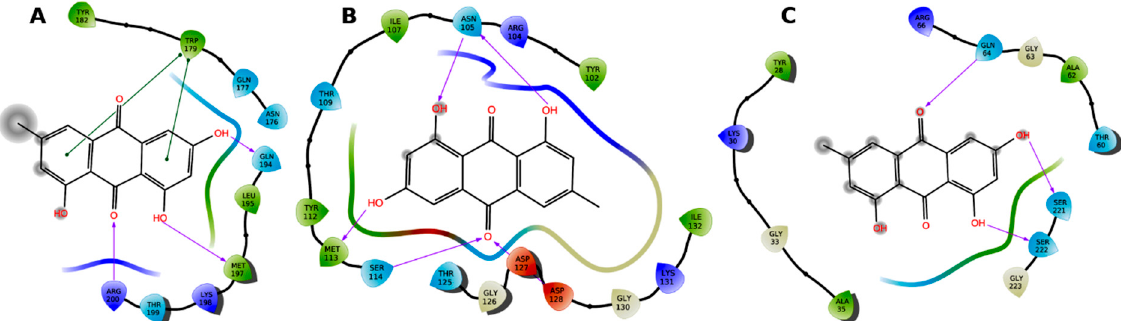
Figure 3. The interaction of emodin with the amino acids in site 1 ( A ), site 2 ( B ) and site 3 ( C ). Hydrogen bonds are shown as arrows and π – π stacking as green lines.